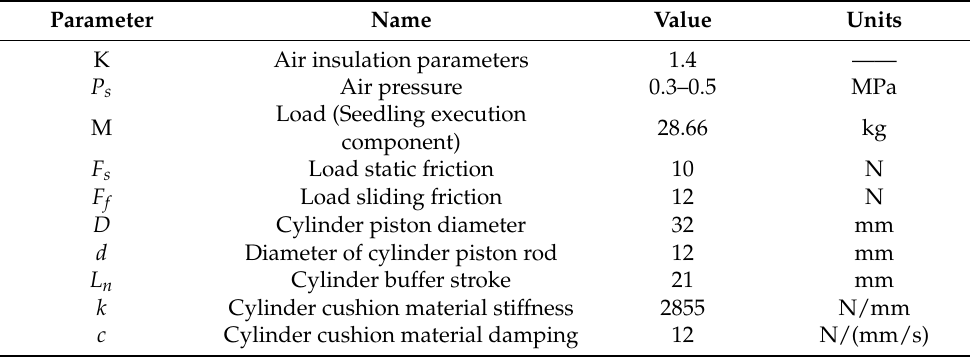
Table 4. Main simulation technical parameters of high-speed